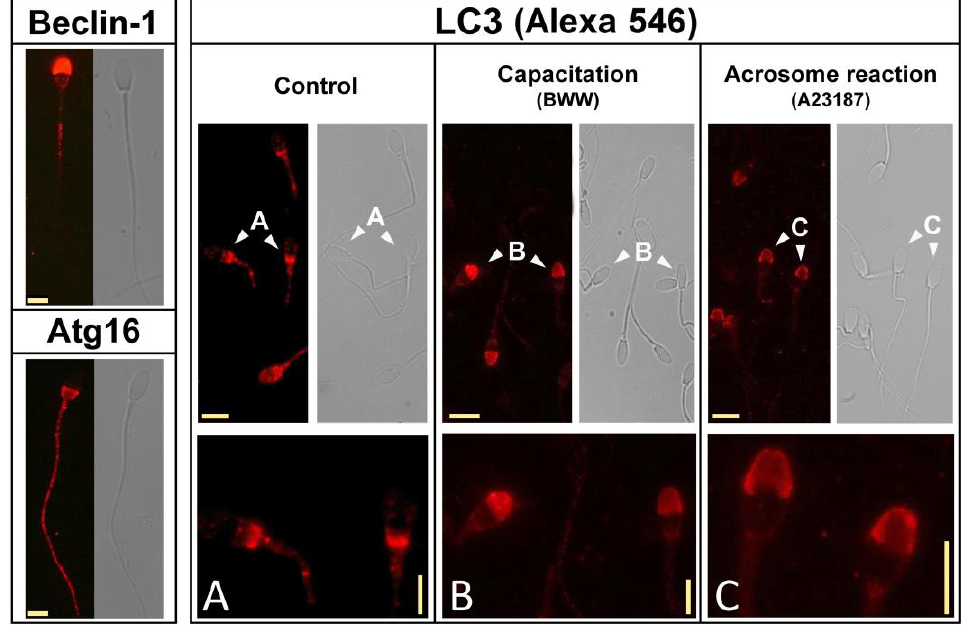
Figure 3. The immunolocalization of autophagy components in stallion spermatozoa and the subcel- lular redistribution of LC3 during capacitation and the acrosome reaction. The subcellular localization of autophagy proteins Beclin-1, Atg16, and LC3 was investigated by immunofluorescence in fixed and permeabilized stallion sperm using specific antibodies (see Materials and Methods section). LC3 subcellular distribution was studied in detail in stallion spermatozoa in basal conditions (Control, left panel), after incubation in BWW for 3 h at 37 ◦ C (Capacitation, middle panel), and after incubation in BWW for 3 h at 37 ◦ C with the addition of 5 µ M A23187 during the last 30 min of incubation (Acrosome reaction, right panel). Bottom figures are representative areas digitally augmented to show the localization of LC3 in each respective panel corresponding to the cells indicated by the arrowheads (( A ), control; ( B ), capacitation; ( C ), acrosome reaction), showing the three different patterns of LC3 distribution in sperm head. The horizontal yellow calibration bar represents 5 µ m, and the vertical yellow calibration bar in the bottom represents 2.5 µ m. The results are representative of 8 independent